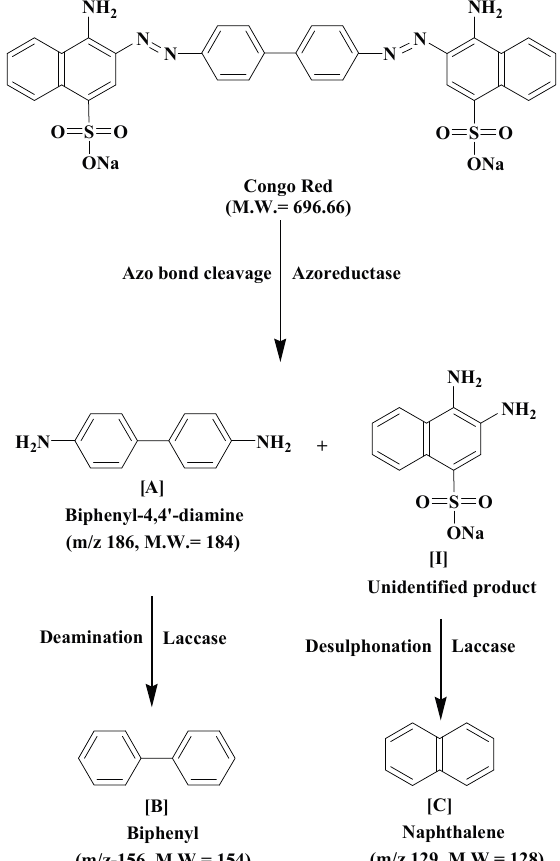
Figure 8. The proposed biodegradation pathway of CR dye by PUF-immobilized microbial consortium in an upflow column